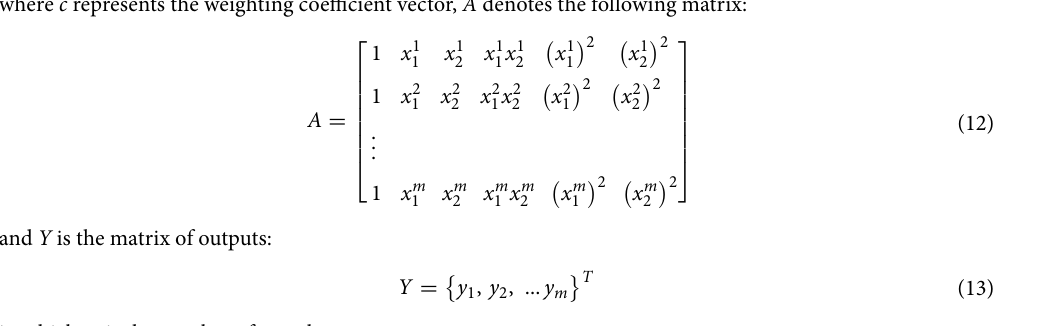
where y is the output, ( x 1 , x 2 ) is the input vector, and c is the weighting coefficient. The intricacy of the neurons will be increased layer by layer, which causes that the final network is becoming complex 67 . The weighting coef-